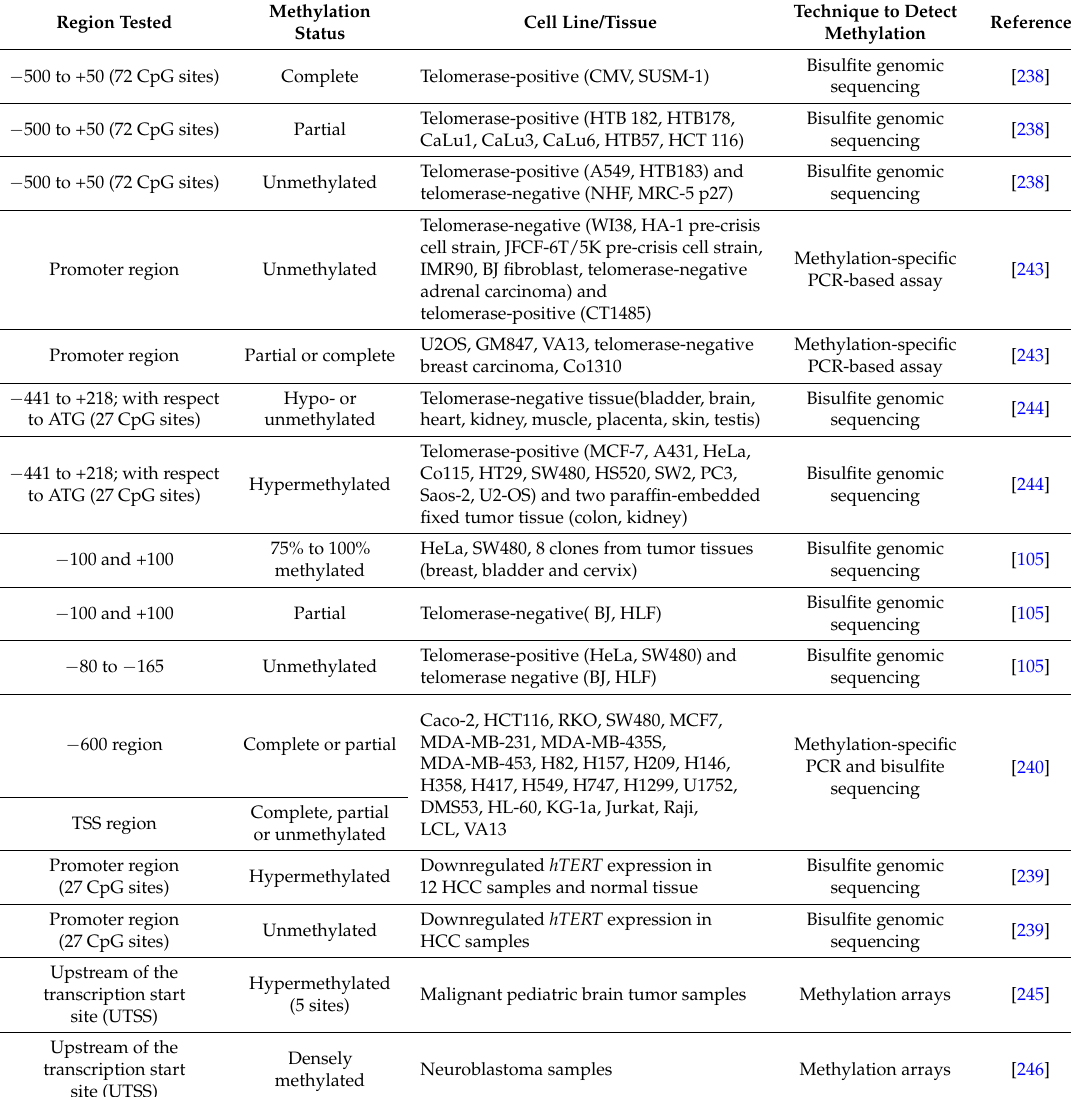
Table 2. Detail of studies which reported methylation status of human telomerase reverse transcriptase ( hTERT ) promoter proximal